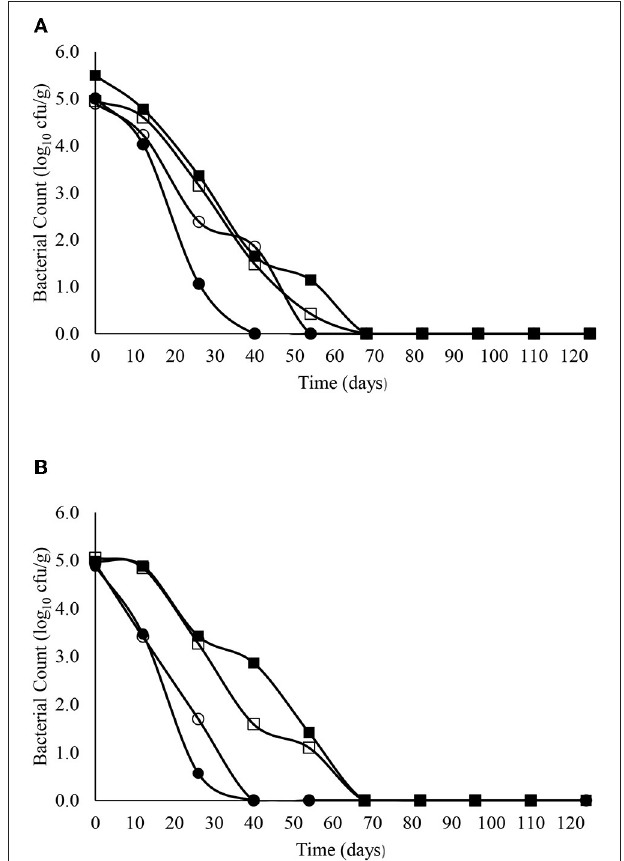
FIGURE 5 | The reduction in L. monocytogenes over time in sandy (A) and clay (B) soils including with slurry at 4 ◦ C ( (cid:4) ), digestate at 4 ◦ C ( (cid:3) ), slurry at 14 ◦ C ( • ) and digestate at 14 ◦ C (o).